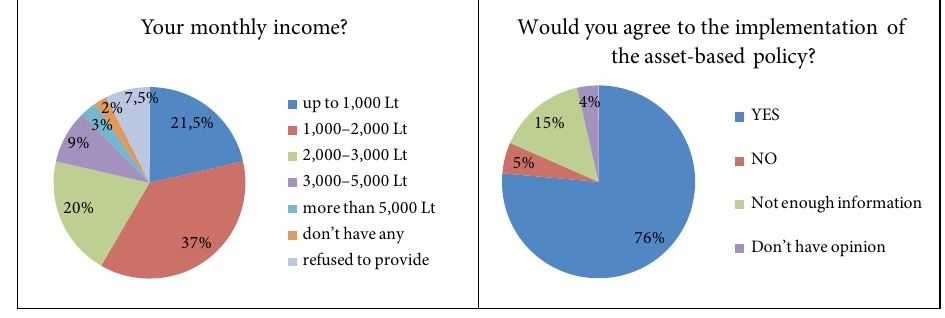
Fig. 6. Distribution of respondents according to their incomes (after paying taxes) (authorial computation, according to the survey data)